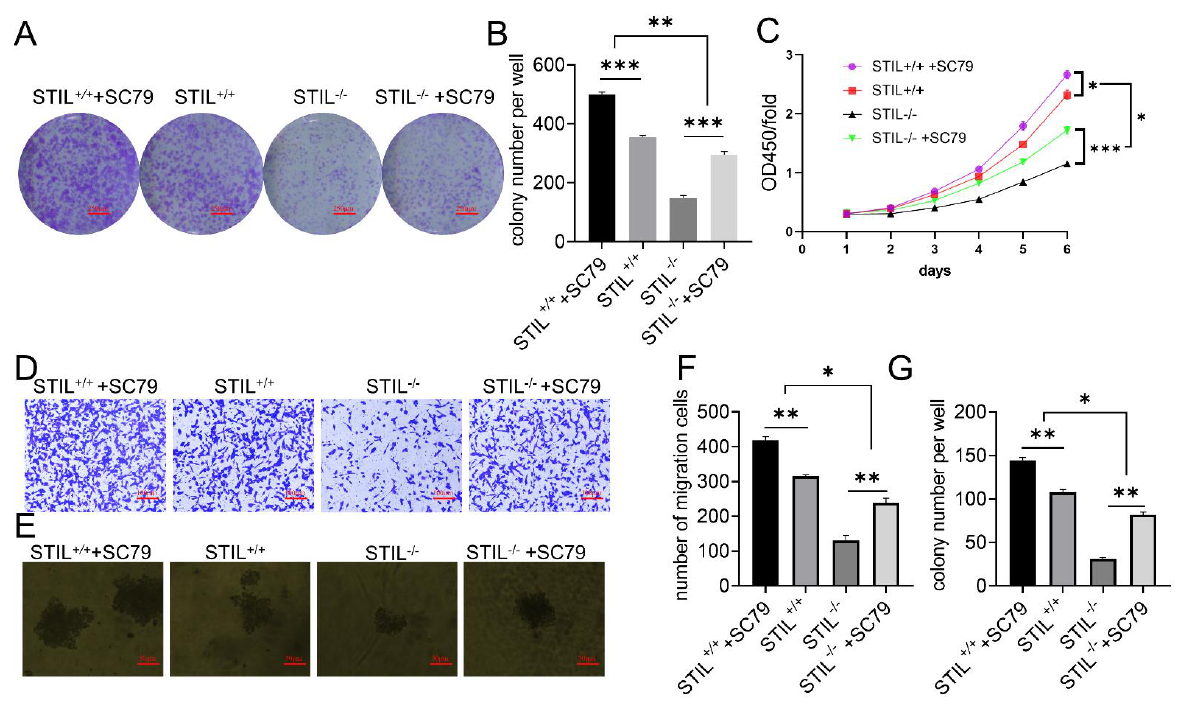
Figure 7. In the UMUC3 cell line, SC79 treatment partially reversed the effect of STIL knockout on cell tumorigenesis. ( A ) Representative microscope images and ( B ) quantitative analysis of colony formation assays. ( C ) Cell proliferation curves of CCK-8 assays. ( D ) Representative microscope images and ( F ) quantitative analysis of transwell migration assay. ( E ) Representative microscope images and ( G ) quantitative analysis of soft agar assay. In all the above experiments, four groups of cells were tested simultaneously (STIL +/+ +SC79, STIL +/+ , STIL − / − , STIL − / − +SC79) (* p < 0.05, ** p < 0.01, and *** p <